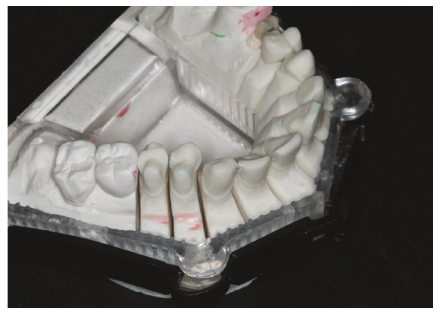
Figure 7: Die-cut